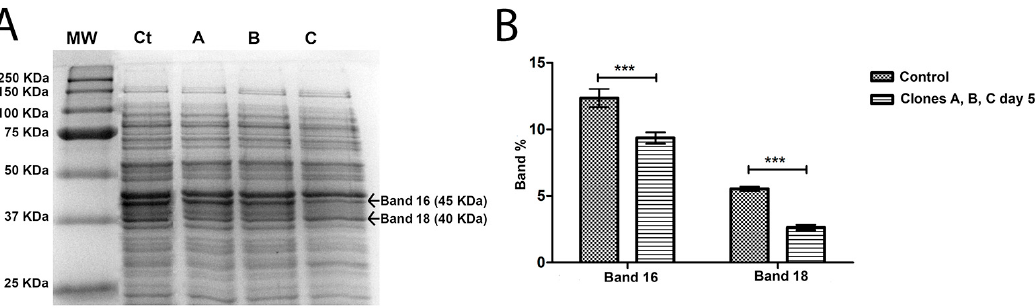
Figure 5. ( A ) SDS PAGE gel of the intracellular proteins of A. salmonicida on fifth streak plating. MW, molecular weight marker; Ct, control phage-sensitive A. salmonicida ; A is Colony A of the phage-resistant A. salmonicida mutant; B is Colony B of the phage-resistant A. salmonicida mutant; C is Colony C of the phage-resistant A. salmonicida mutant. The marked bands are the ones that showed differential expression between control and clones A, B and C. Band weight is expressed in kilodalton (KDa). ( B ) Differential expression of the bands, in percentage, comparing Control ( phage-sensitive A. salmonicida ) with clones A, B and C (phage-resistant A. salmonicida ) after 5 streak-plating steps. *** p < 0.001. In total, 39 bands were detected and compared, in the control and A. salmonicida clones, both in